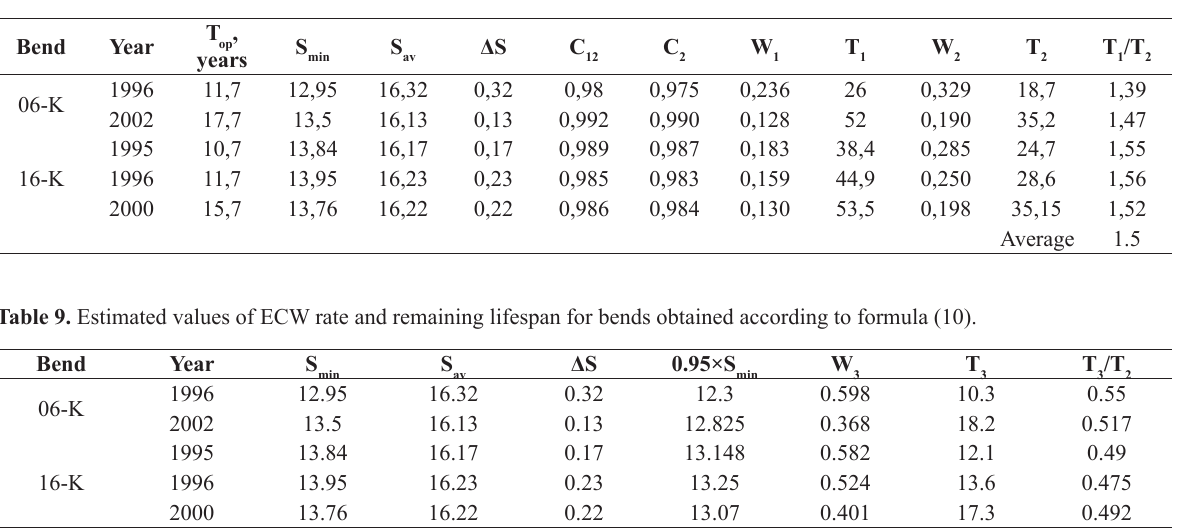
and Т ) for bends obtained according to formula (1) taking into 4 4